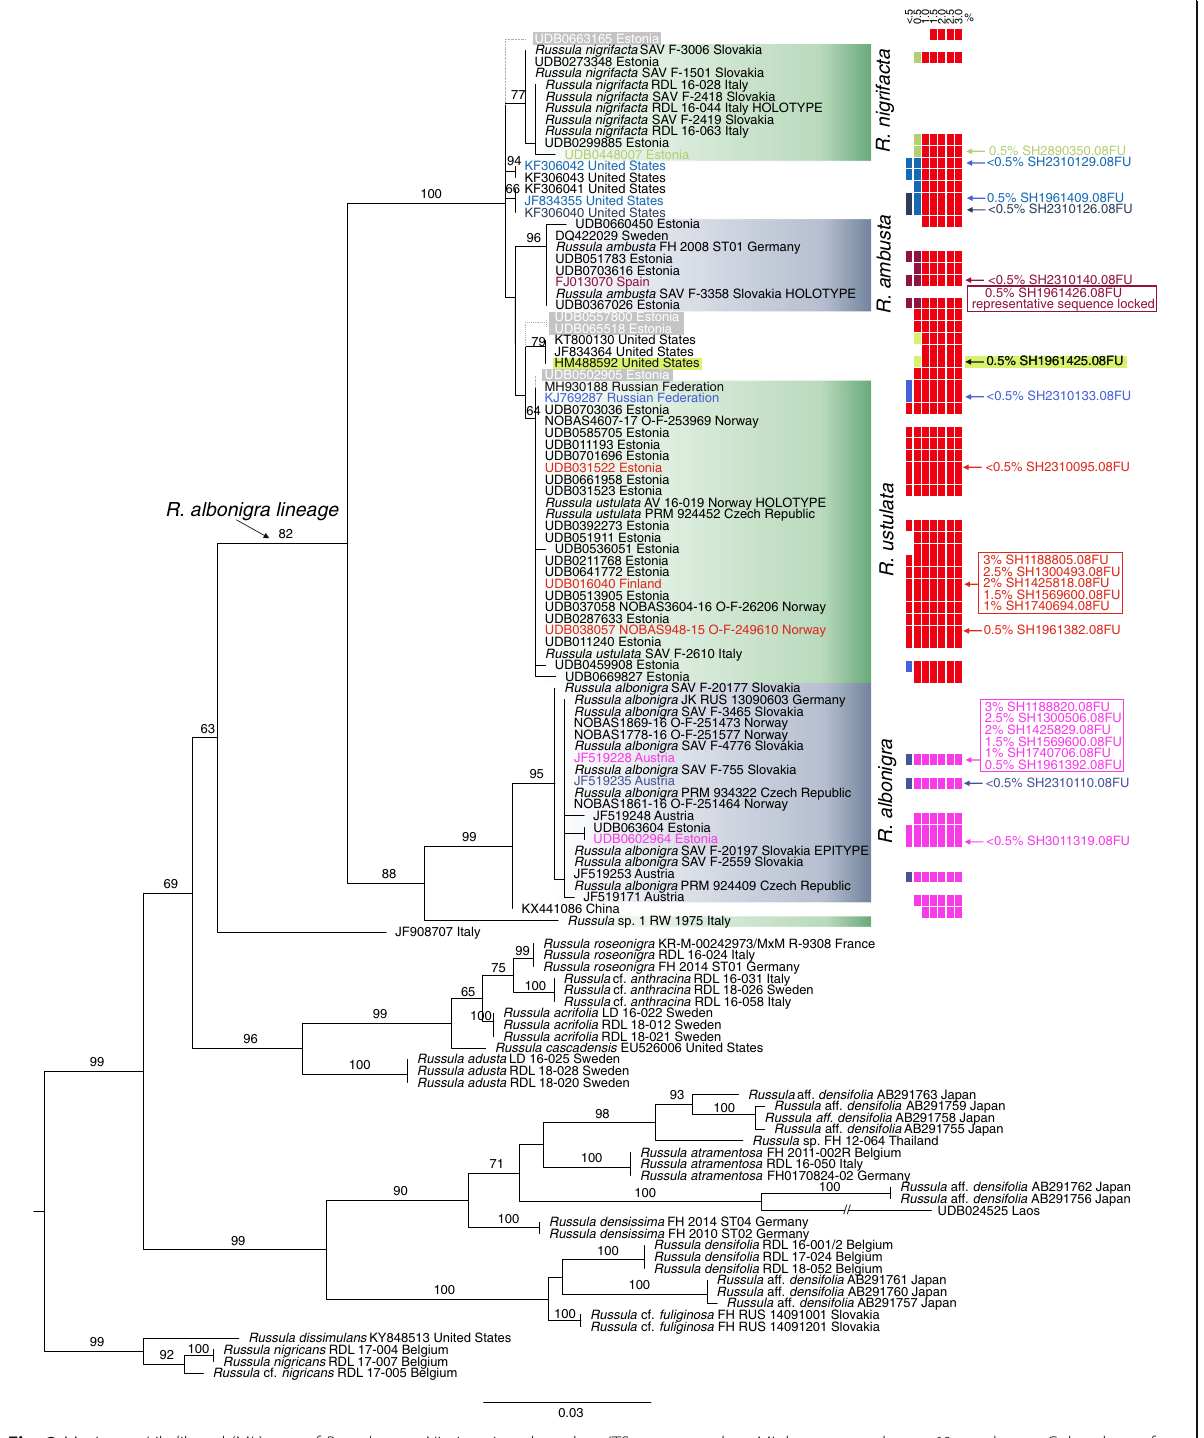
Fig. 2 Maximum Likelihood (ML) tree of Russula sect. Nigricantinae , based on ITS sequence data. ML bootstrap values >60 are shown. Colour bars of similar colour within each column represent individual UNITE species hypotheses. Missing bars represent unresolved clustering. Samples in colour are representative sequences labelled with SH numbers. Grey shaded samples in white are plotted to the tree based on similarities in distinguishing nucleotide positions (uncertain positions are labelled by grey dotted